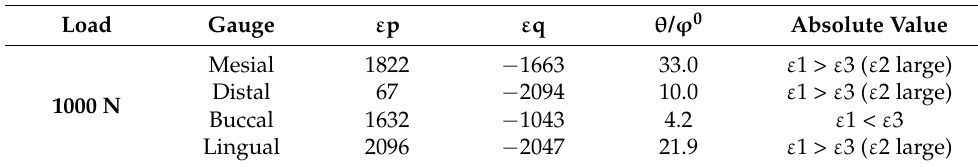
Table 2. Principal strains and their orientations. It is clarified here that, although the positive and negative values of the principal strains refer to tensile and compressive strains, respectively, the overall understanding of the directions of the strains is gained when the angular orientation is